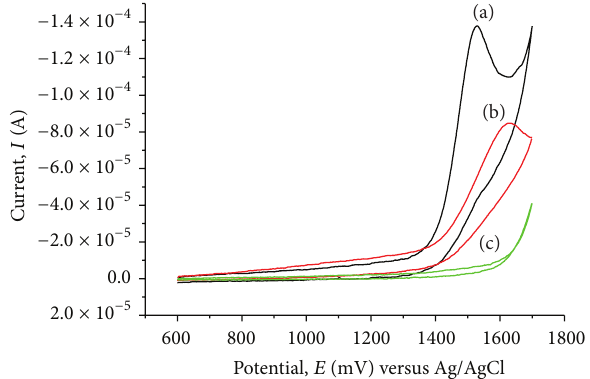
Figure 1: Cyclic voltammograms: (a) AQMCPE, (b) UMCPE, in the presenceof1 mMCAFin0.1moLL −1 HClO 4 (pH0.56),atascanrate of 100mVs −1 , and (c) AQMCPE in the absence of 1mM CAF.